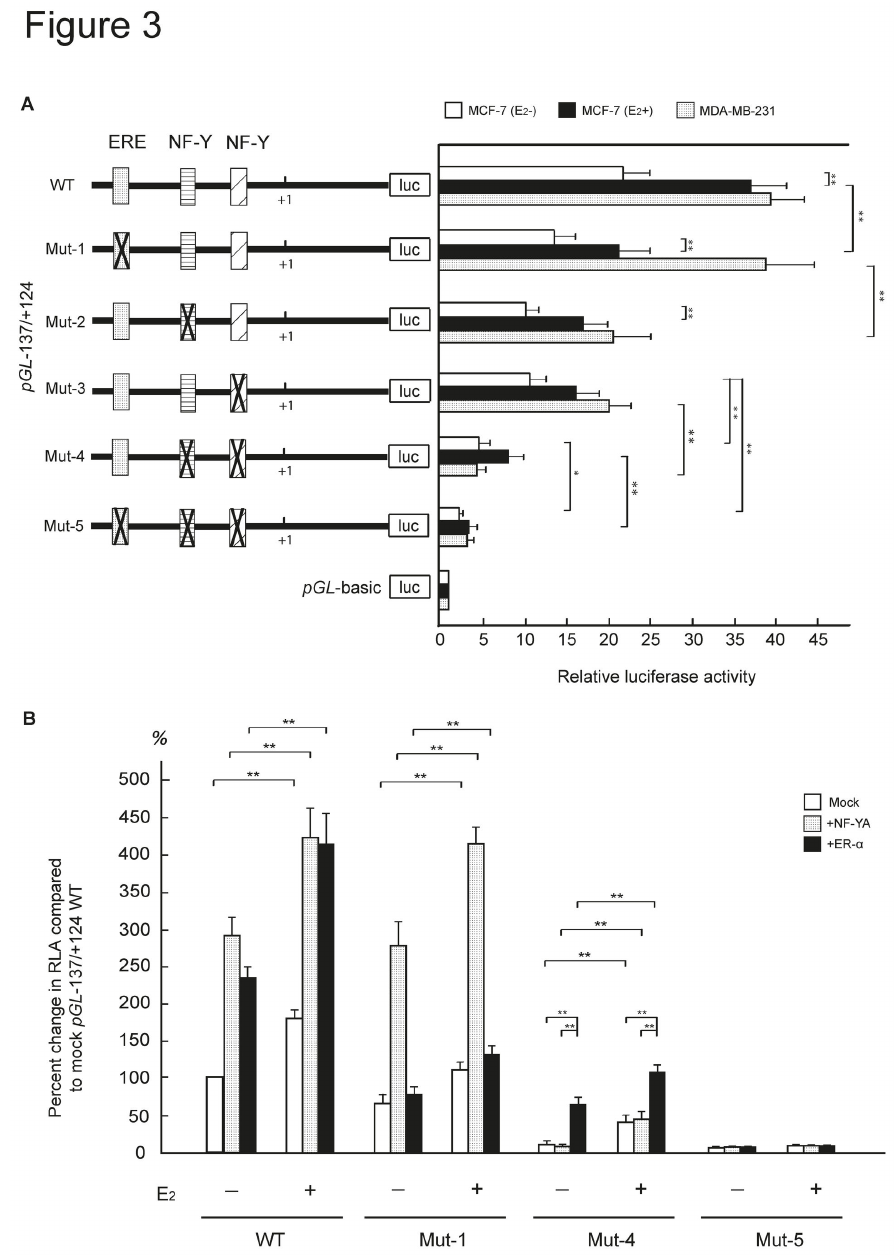
Figure 3. Identification of cis -elements of the UBC promoter. ( A ) Site-directed mutagenesis was carried out with the UBC9 pGL-137/+124 construct. The mutation of a putative transcription factor binding site is indicated by a solid cross. MCF-7 cells cultured in phenol red-free medium in the absence (white bars) or the presence (black bars) of E and and MDA-MB-231 cells 2 (dotted bars) were transfected with the indicated constructs and assayed for luciferase activity after 48 hours. Luciferase activity was expressed as fold change relative to that obtained from promoterless vector pGL -basic, which was arbitrarily set to 1. Values were normalized for transfection efficiency by co-transfection with the Renilla expression plasmid and were expressed as mean ±SD obtained in four separate experiments. *P<0.05, **P<0.01 (Student’s t -test). ( B ) Enhancement of the UBC9 promoter activity by ER- α or NF-YA overexpression. Untreated and E -treated MCF-7 cells were transfected with WT, Mut-1, Mut-4 and Mut-5 pGL -137/+124 2 constructs, NF-YA (dotted bars) or ER-α (black bars) expression plasmids. Mock transfected cells were used as a control (white bars). Relative luciferase activity (RLA) was expressed as fold change relative to that obtained from pGL-137/+124 (E -), which was 2 arbitrarily set to 1. Values were normalized for transfection efficiency by co-transfection with the Renilla expression plasmid and were expressed as mean ±SD obtained in four separate experiments. **P<0.01 (Student’s t -test). doi: 10.1371/journal.pone.0075695.g003 PLOS ONE |